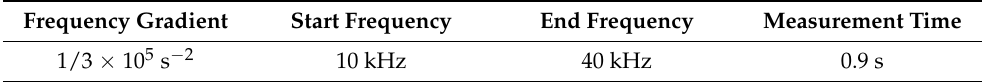
Table 6. Measurement parameters for the modal analysis.